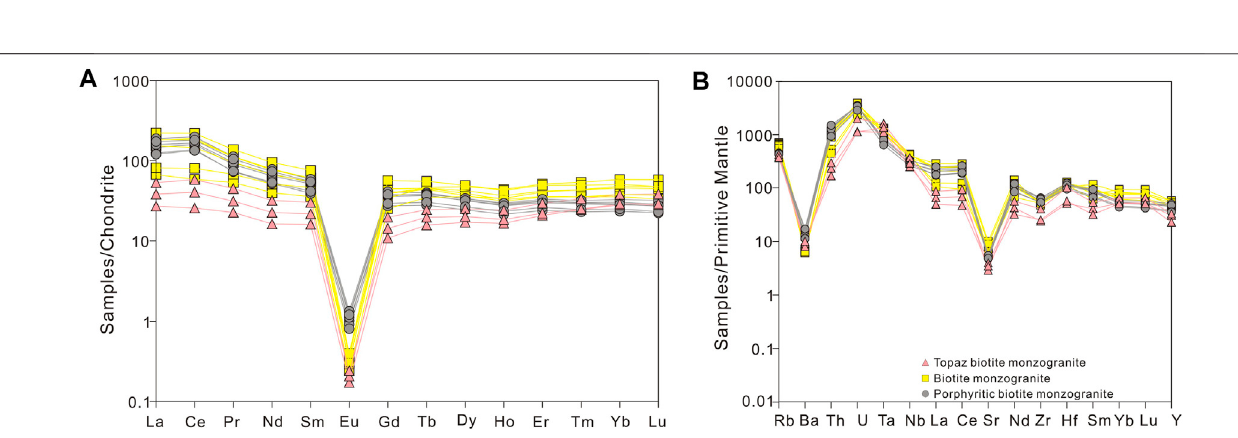
Frontiers in Earth Science |